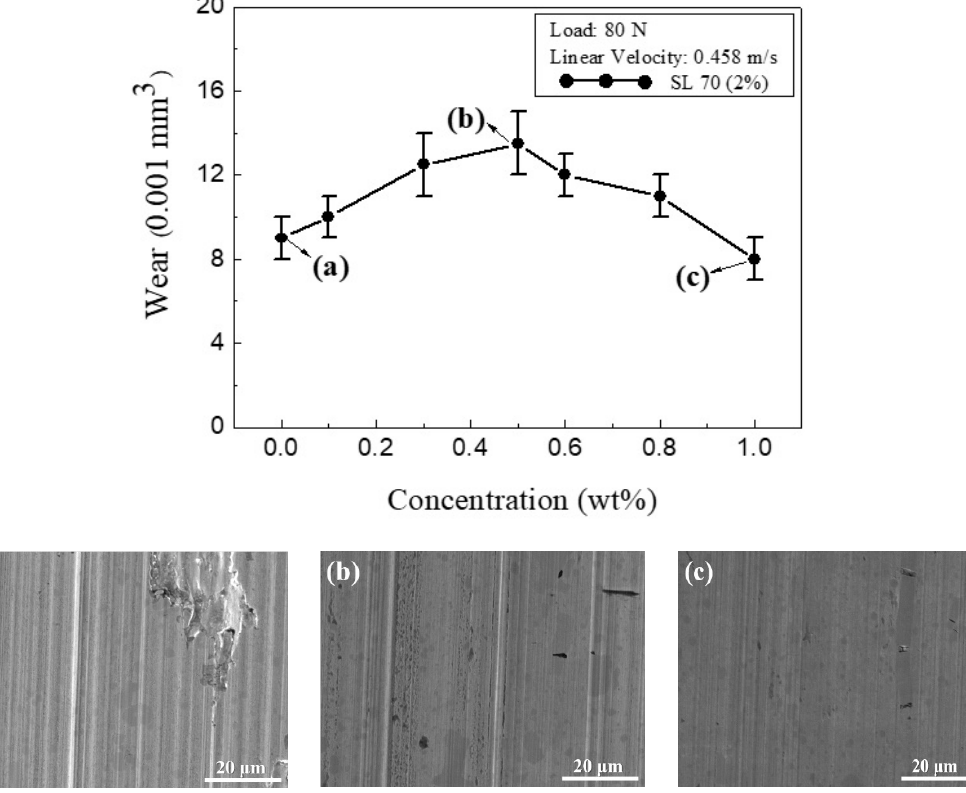
Figure 6. Variation of wear volume with CNC concentration in water working fluid. SEM images show wear surfaces following sliding with water lubricant with ( a ) 0 wt.%, ( b ) 0.5 wt.%, and ( c ) 1.0 wt.% CNC additions.